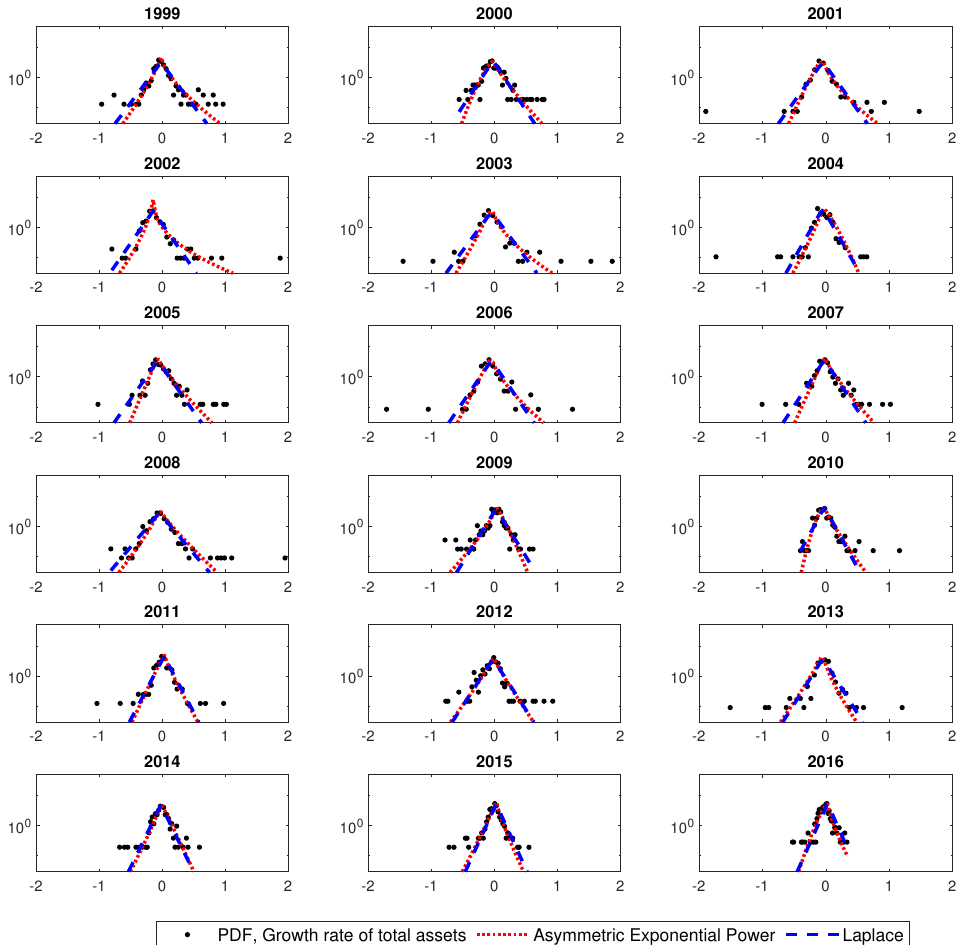
Figure A2. Probability Density Function (PDF) of growth rates of total assets along with the AEP (dotted line) and Laplace (dashed line) distributions. The results refer to the 200 largest long-lived firms according to their sales in